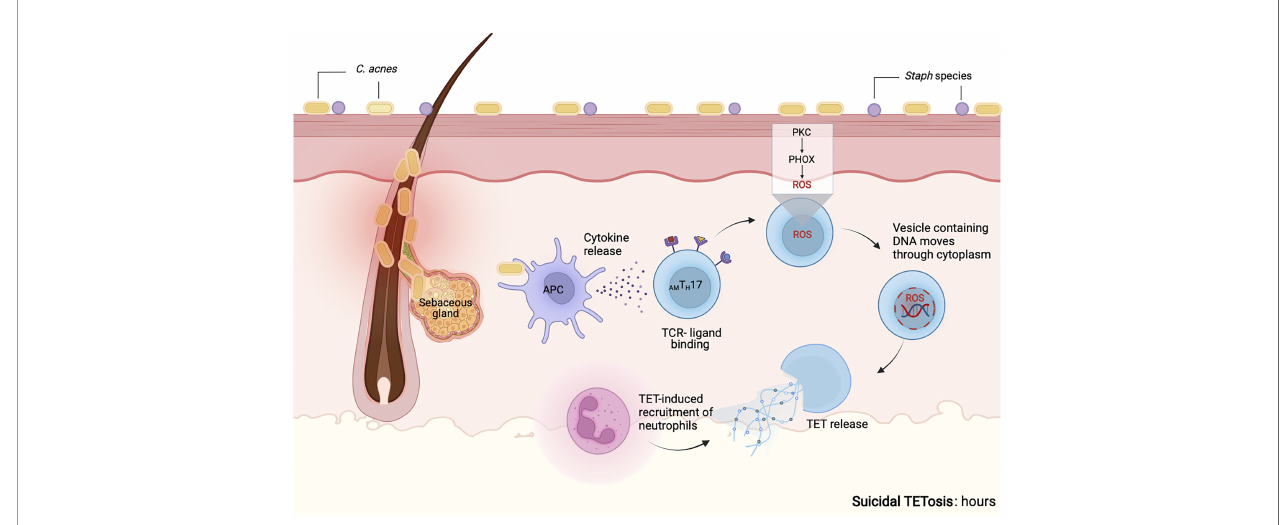
FIGURE 5 | Proposed mechanism for suicidal TETosis. Similar to neutrophils, we propose that upon activation of TLR and receptors for IgG-Fc, complement or cytokine receptors on T cells, calcium is released from the endoplasmic reticulum into the cytoplasm. Higher levels of calcium within the cytoplasm, promote the activity of protein kinase C (PKC). This further induces the assembly of both the membrane-bound and cytosolic subunits of NADPH oxidase (phagocytic oxidase, PHOX) into functional complexes. This is followed by the release of reactive oxygen species (ROS), that causes the granules and the nuclear envelope to rupture. Following rupture both the nuclear and cytoplasmic contents are able to mix. Enzymes associated with the nucleus and the cytoplasm go on to degrade the linker histone H1, further processes the core histones (H2A, H2B, H3 and H4) and amplify the decondensation of chromatin. These events eventually lead to the rupture of the plasma membrane and the TETs are released into the extracellular space (160). The release of TETs can lead to T cell death and the loss of viable T cell functions such as antigen recognition and cytokine release. Enzymes that may mediate the proposed molecular processes are not known. Created with